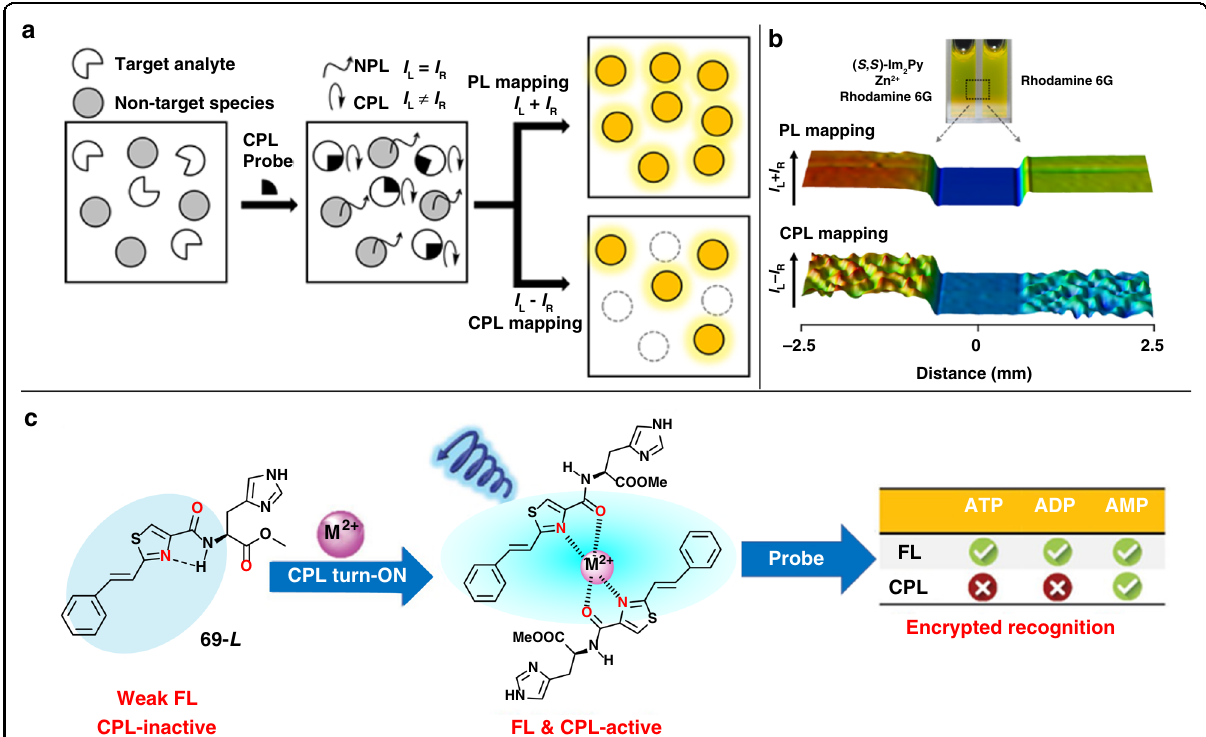
Fig. 10 Applications in chemical and biological sensing. a Schematic illustration of sensor methodologies based on CPL signal. b Photoluminescence mapping and CPL mapping for the target analyte system and non-target specie system. c Illustration of encrypted selective recognition of AMP. Images reprinted with permission from: a , b ref. 126 ; c ref. 131 from